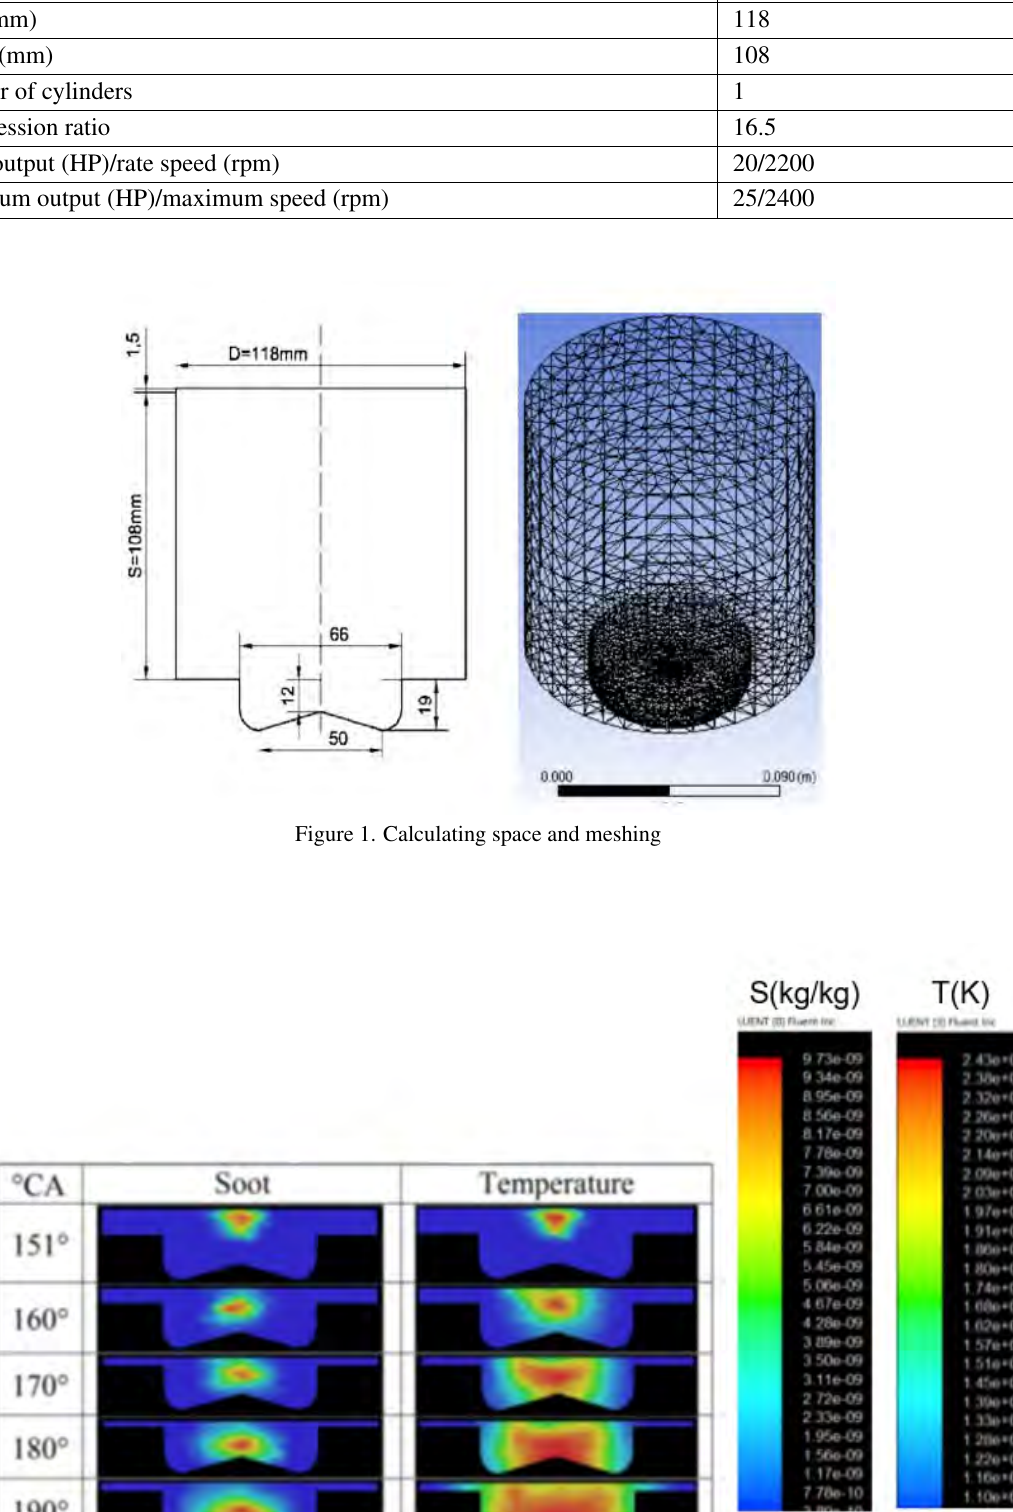
Figure 2. Soot and temperature distribution in combustion chamber (D15, ϕ =1.1, n=2400 rpm)